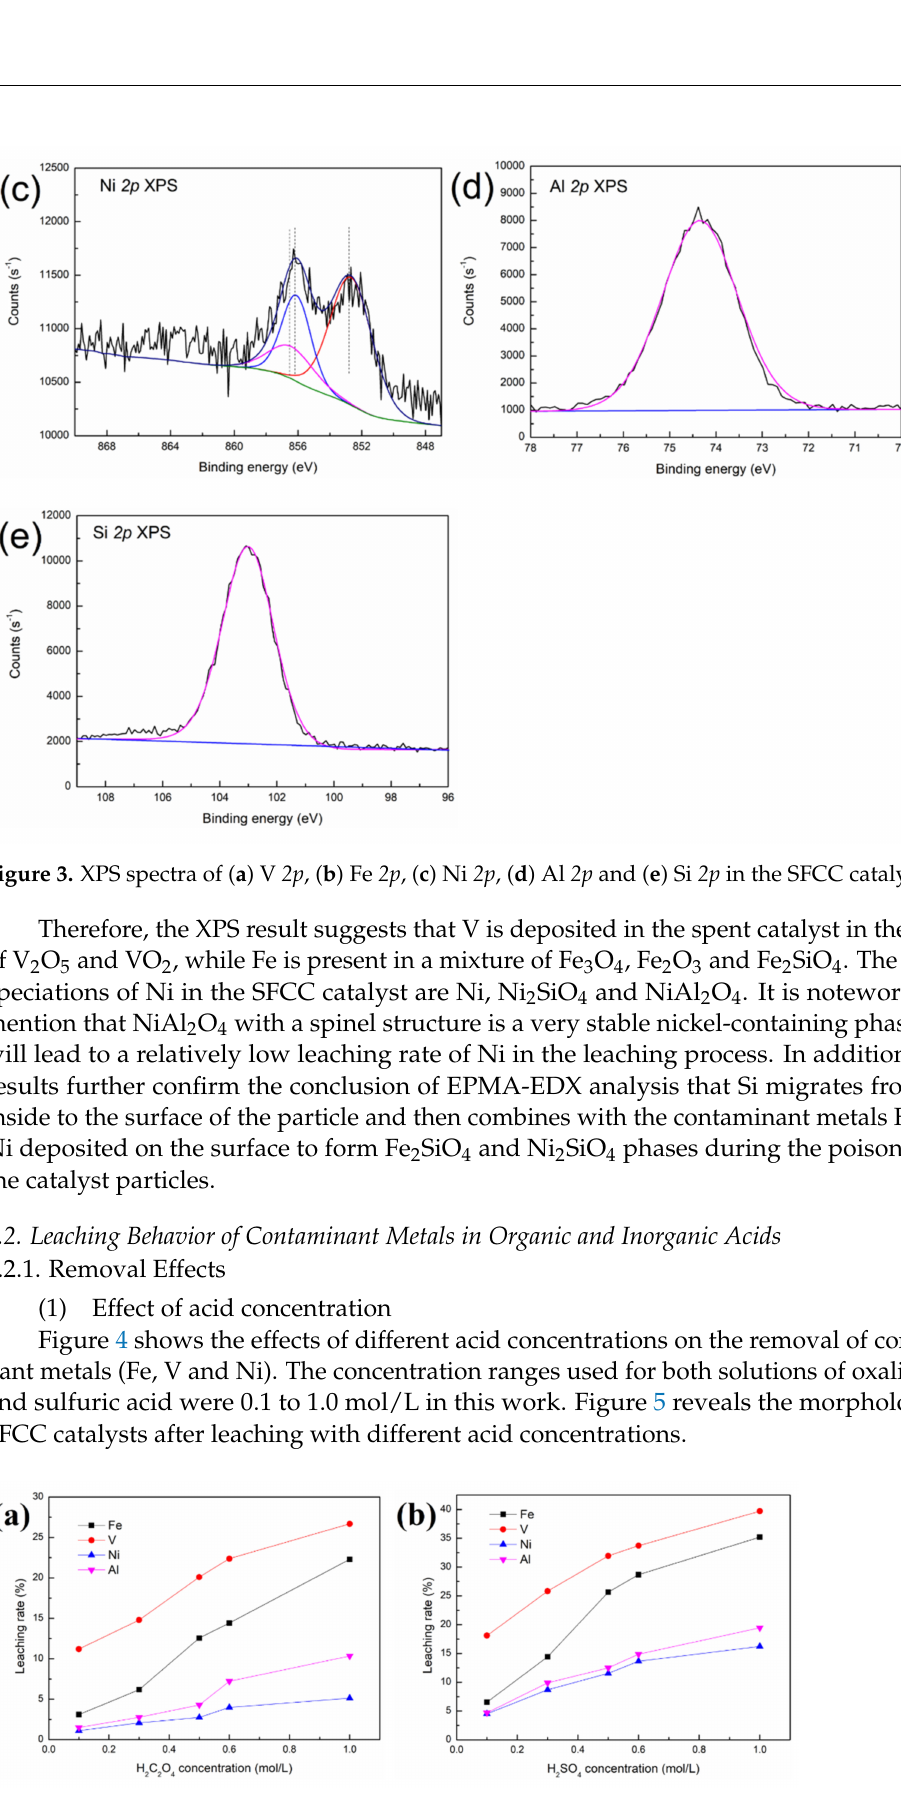
Figure 4. Effect of acid concentration on the removal of contaminant metals from the SFCC catalyst: ( a ) in oxalic acid; ( b ) in sulfuric acid 4 g SFCC catalyst, 80 ◦ C, 30 min, S/L = 1:10, 400 W, 2450 MHz, 2 kg/cm 2